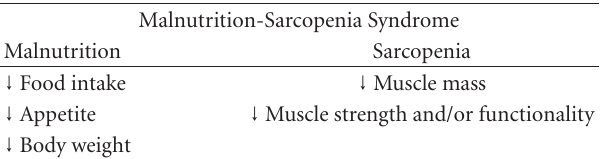
Table 2: The clinical signs and symptoms of Malnutrition- Sarcopenia